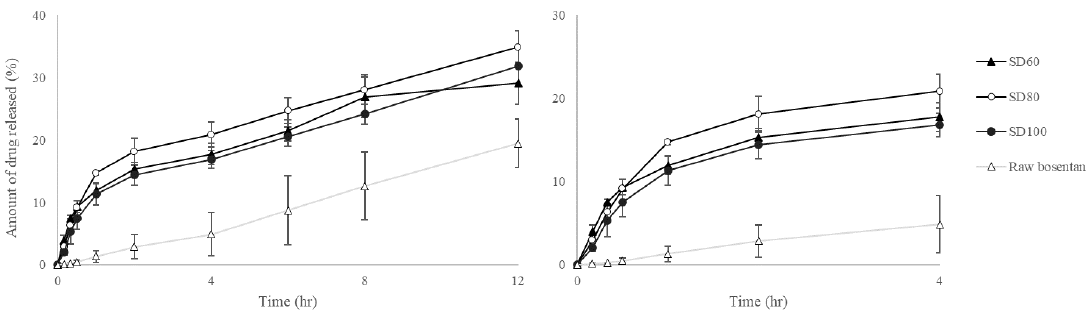
Figure 5. Dissolution profiles of spray-dried bosentan microparticles and raw bosentan in Franz di ff usion cell. Table 3. First-order kinetic and MDT of SD formulations and raw bosentan in a Franz di ff usion cell.